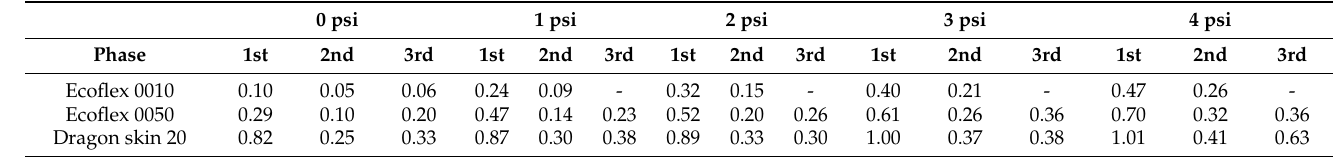
Table 3. Structural modulus (MPa) of different sensor samples indented by the 6 mm indenter.